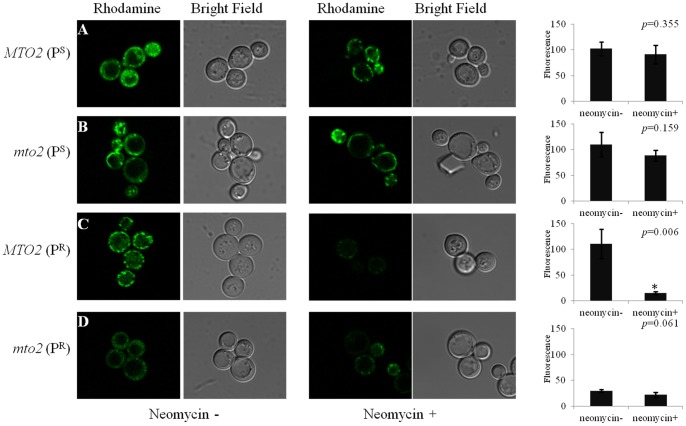

In vivo staining of the mitochondrion to measure the membrane potential by Rhodamine 123 dyes.2×106 cells in 1 ml supernatant were incubated with Rhodamine 123 (5 µg/ml) for 20 min at 30°C. Cell pellets were resuspended in 20 µl PBS and visualized with Carl Zeiss 710 LSM microscopy. The relative fluorescence signal of each strain is shown in the right panel.